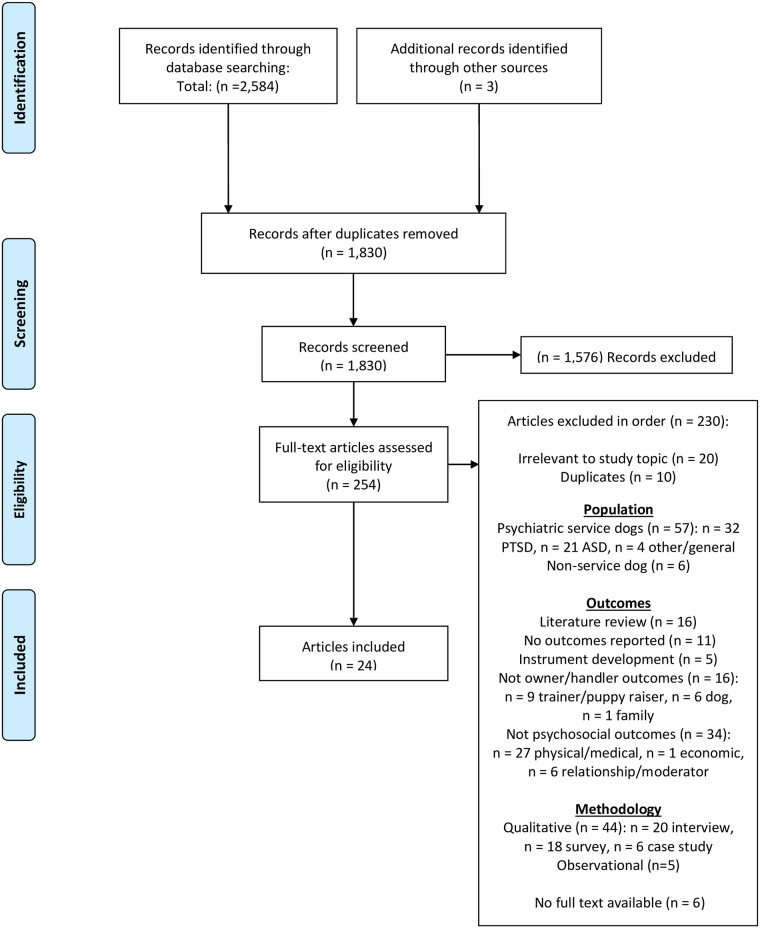
PRISMA flow diagram.